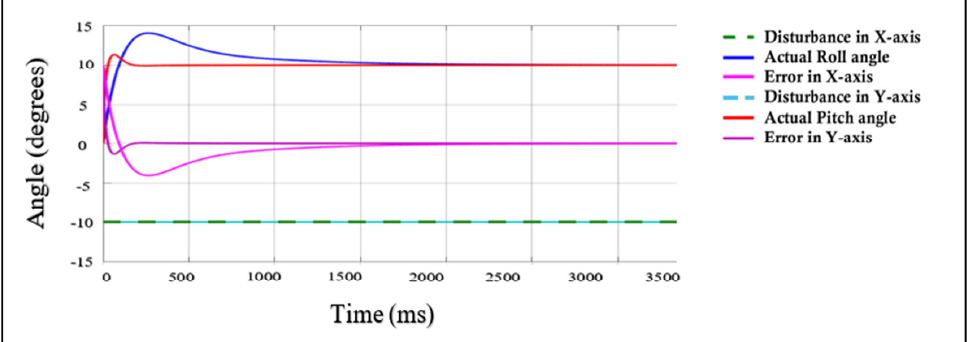
Fig. 16. Self-balancing behavior of simulated model on (similar tilt angles in X-axis and Y-axis).